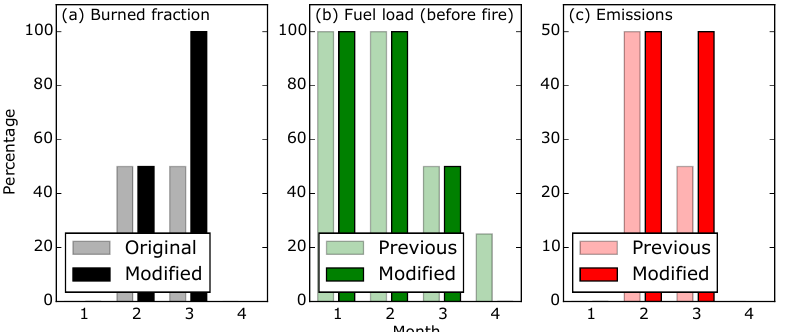
Figure 6. Burned area, fuel load, and emissions for a hypothetical grid cell where 50% of the area burns in month 2 and 50% in month 3, and assuming a combustion completeness of 100%. “Previous” refers to our previous work in GFED3 and before where no adjustments were made in the conversion of burned area to the fraction of fuel load that is combusted; “modified” refers to the current approach (GFED4 and GFED4s), where we treat the burned fraction as the fraction of the total remaining fuel in the grid cell that is combusted using Eq. (3). Table 1. Emission factors for different fire types, in g specie per kg dry matter burned. Emission factors for other species, uncertainties, and source information is provided in http://www.geo.vu.nl/~gwerf/GFED/GFED4/ancill/GFED4_Emission_Factors.xlsx. Dry matter carbon content (DMCC) was derived from the carbonaceous species and used to convert carbon to dry matter. Specie Savanna Boreal Temperate Tropical Peat Agriculture Mean emissions forest forest forest (Tgyr − 1 ) CO 2 1686 1489 1647 1643 1703